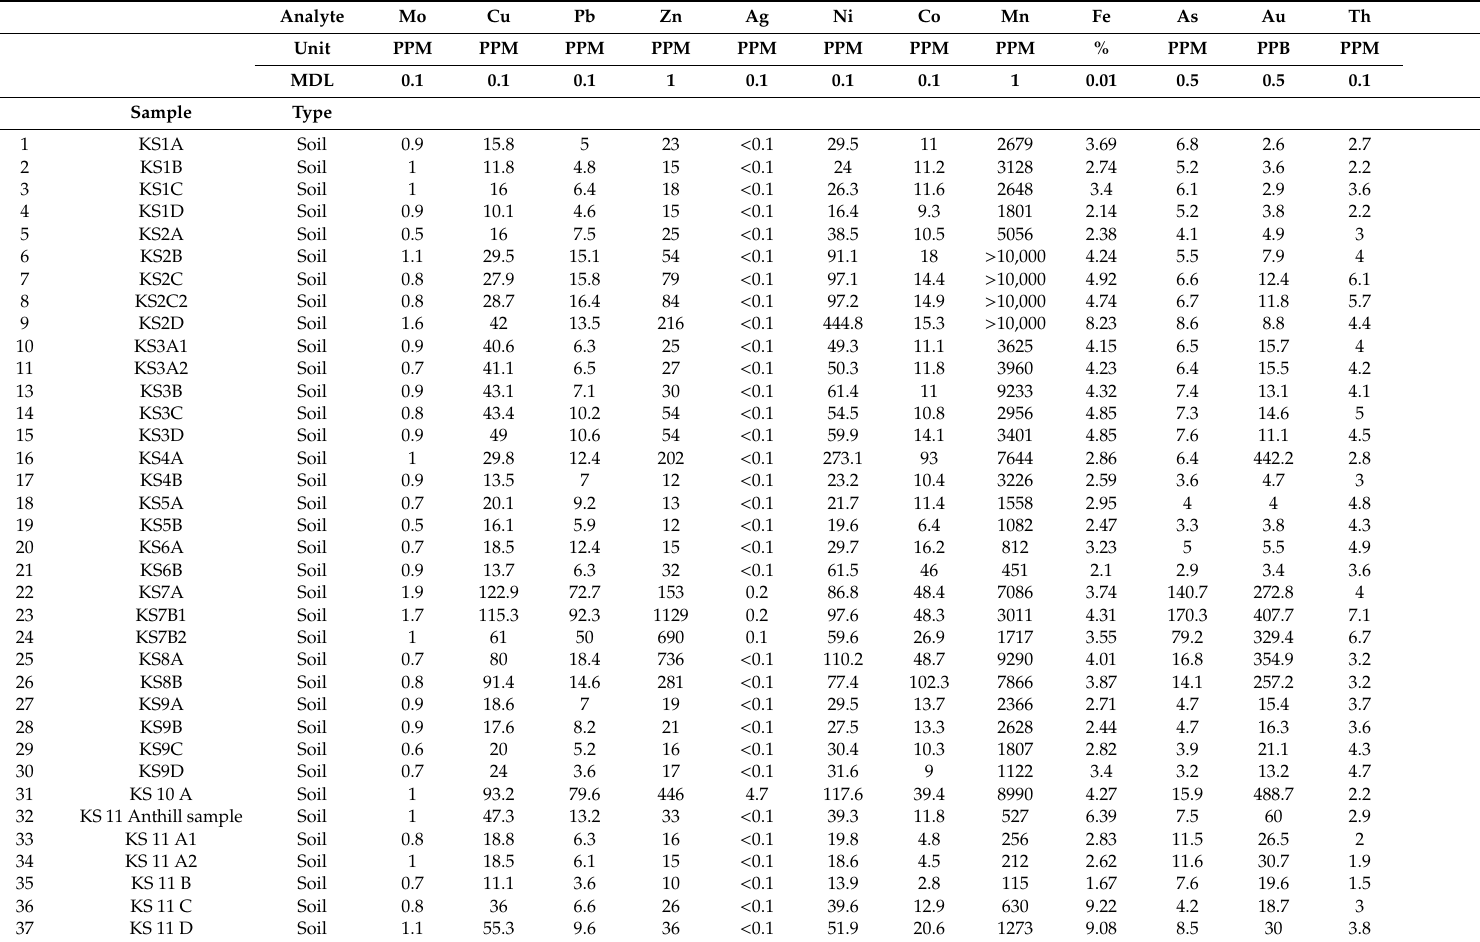
Table 2. Full table of Krugersdorp Game Reserve soil samples analytical potentially harmful elements (PHEs)